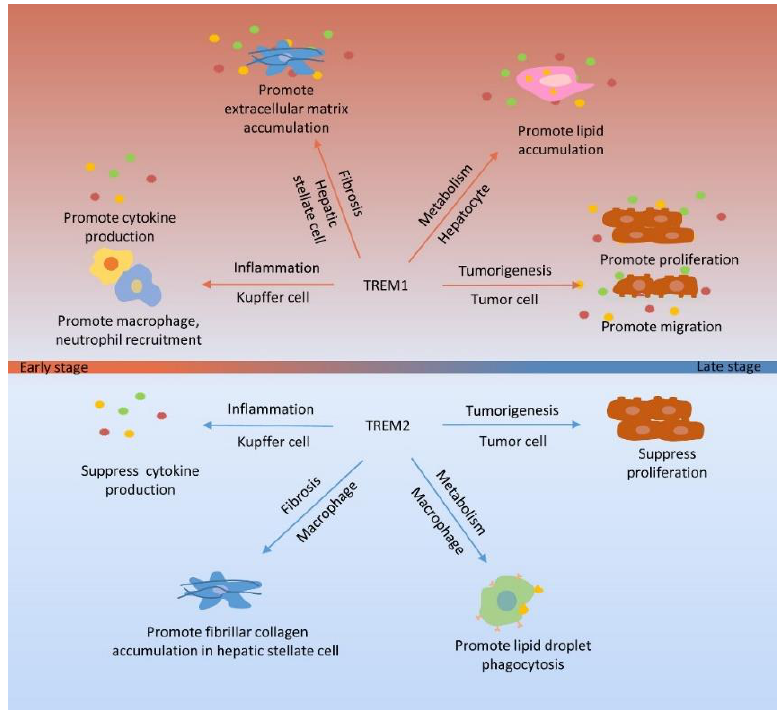
Figure 3. The biological process of TREM1 and TREM2 involved in liver-related diseases. In the early stage of liver-related diseases, the biological function of TREM1 is dominant. To maintain homeostasis, the biological function of TREM2 gradually occupies a dominant position in the late stage. In the inflammatory response, TREM1 expressed on Kupffer cells upregulates production of cytokines and recruits macrophages and neutrophils, which augments inflammation. However, TREM2 expressed on Kupffer cells suppresses production of cytokines. In fibrosis process, pro-inflammatory response of Kupffer cells induced by TREM1 activates hepatic stellate cells. TREM1 also promotes the deposition of extracellular matrix in hepatic stellate cells. TREM2 expressed on macrophages promotes fibrillar collagen accumulation in hepatic stellate cells. In metabolic regulation, TREM1 expressed on hepatocytes promotes lipid accumulation, which causes lipotoxicity to hepatocytes. TREM2 expressed on macrophages increases the phagocytosis of lipid droplet. In tumorigenesis process, TREM1 expressed on tumor cells promotes proliferation and migration, but TREM2 is to suppress proliferation of tumor cells. TREM, triggering receptors expressed on myeloid cells.